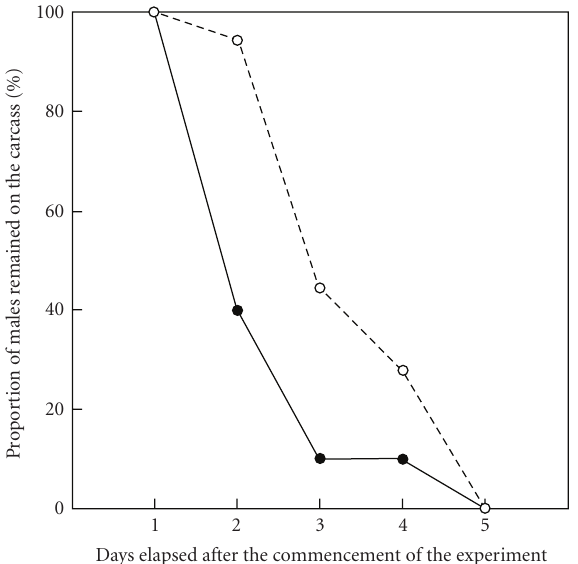
Figure 1: The proportion males of N. quadripunctatus remained on the small (solid circle) and medium carcasses (open circle) where the maternal feeding occurred.